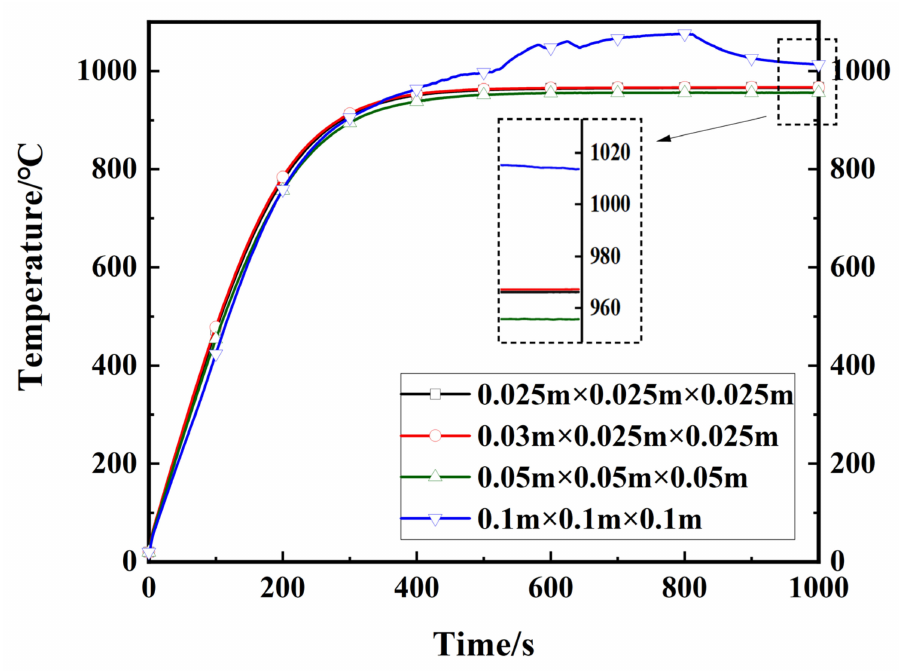
Figure 2. The temperature curve at the heat source center.